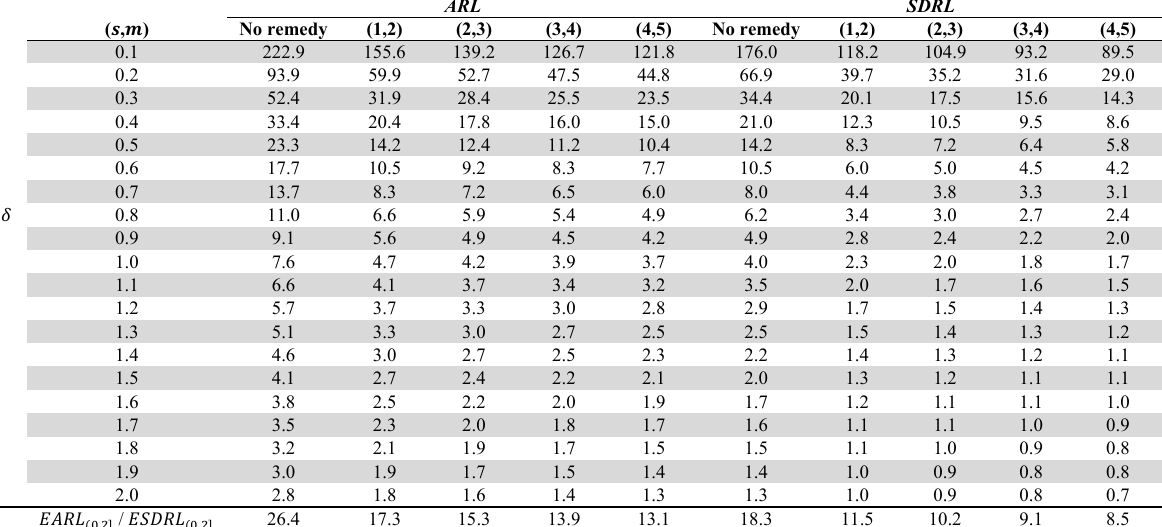
The 𝐴𝑅𝐿 and 𝑆𝐷𝑅𝐿 profiles of the HWMA 𝑋(cid:3364) ∗ scheme (for the mixed- s & m strategy) with a constant variance when 𝑛 =5, =500 with 𝑠 ∈ {1,2,3,4} and 𝑚 ∈ {2,3,4,5} 𝜆 =0.1, 𝜙 =0.75, 𝛾 =0.75, 𝐿 ∗ =2.938, 𝐴𝑅𝐿 (cid:2868)